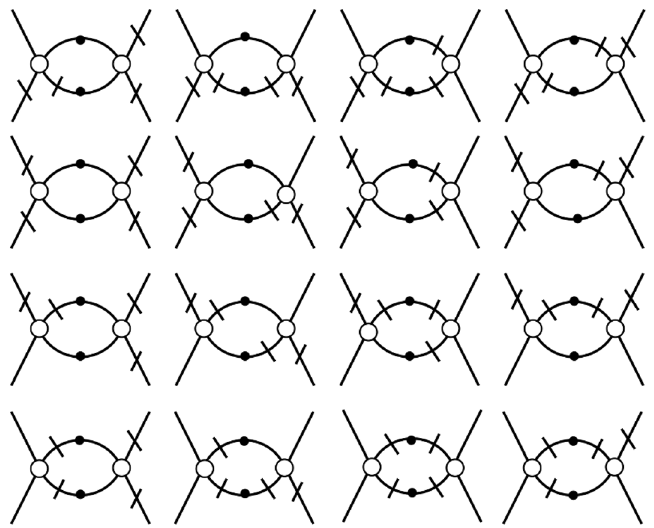
Figure 12 . Set of 1-loop integrals from the double-trace Lagrangian contributing to the amplitude A ( ∂∂ )( ∂∂ )